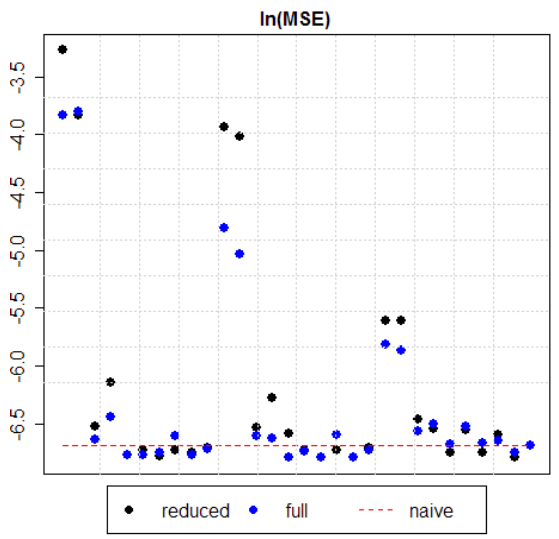
Figure 2. Prediction quality: ln(MSE) of “reduced” vs. “full” models.